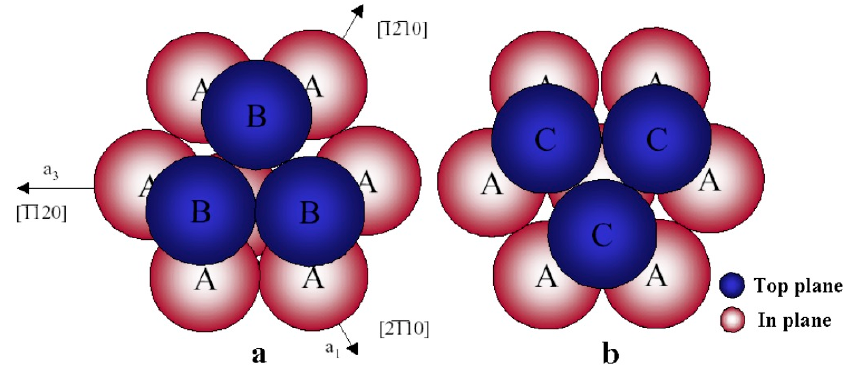
Figure 10. Possible stacking orientations of atoms in a close packed hexagonal structure [70].